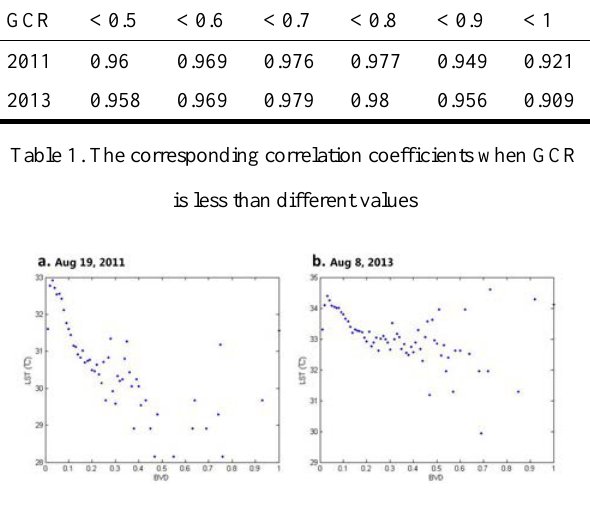
Figure 7. Relationship of mean LST to building volume